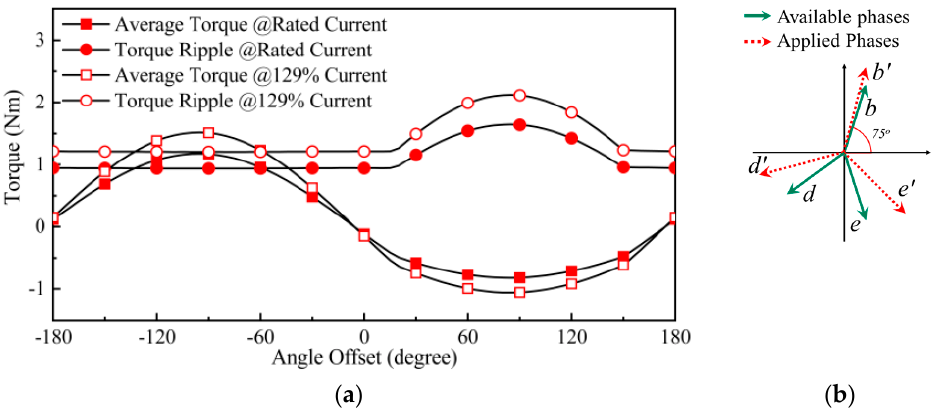
Figure 8. ( a ) Torque with respect to the offset angle for two non-adjacent phase faults; ( b ) proposed solution for two non-adjacent phase faults.